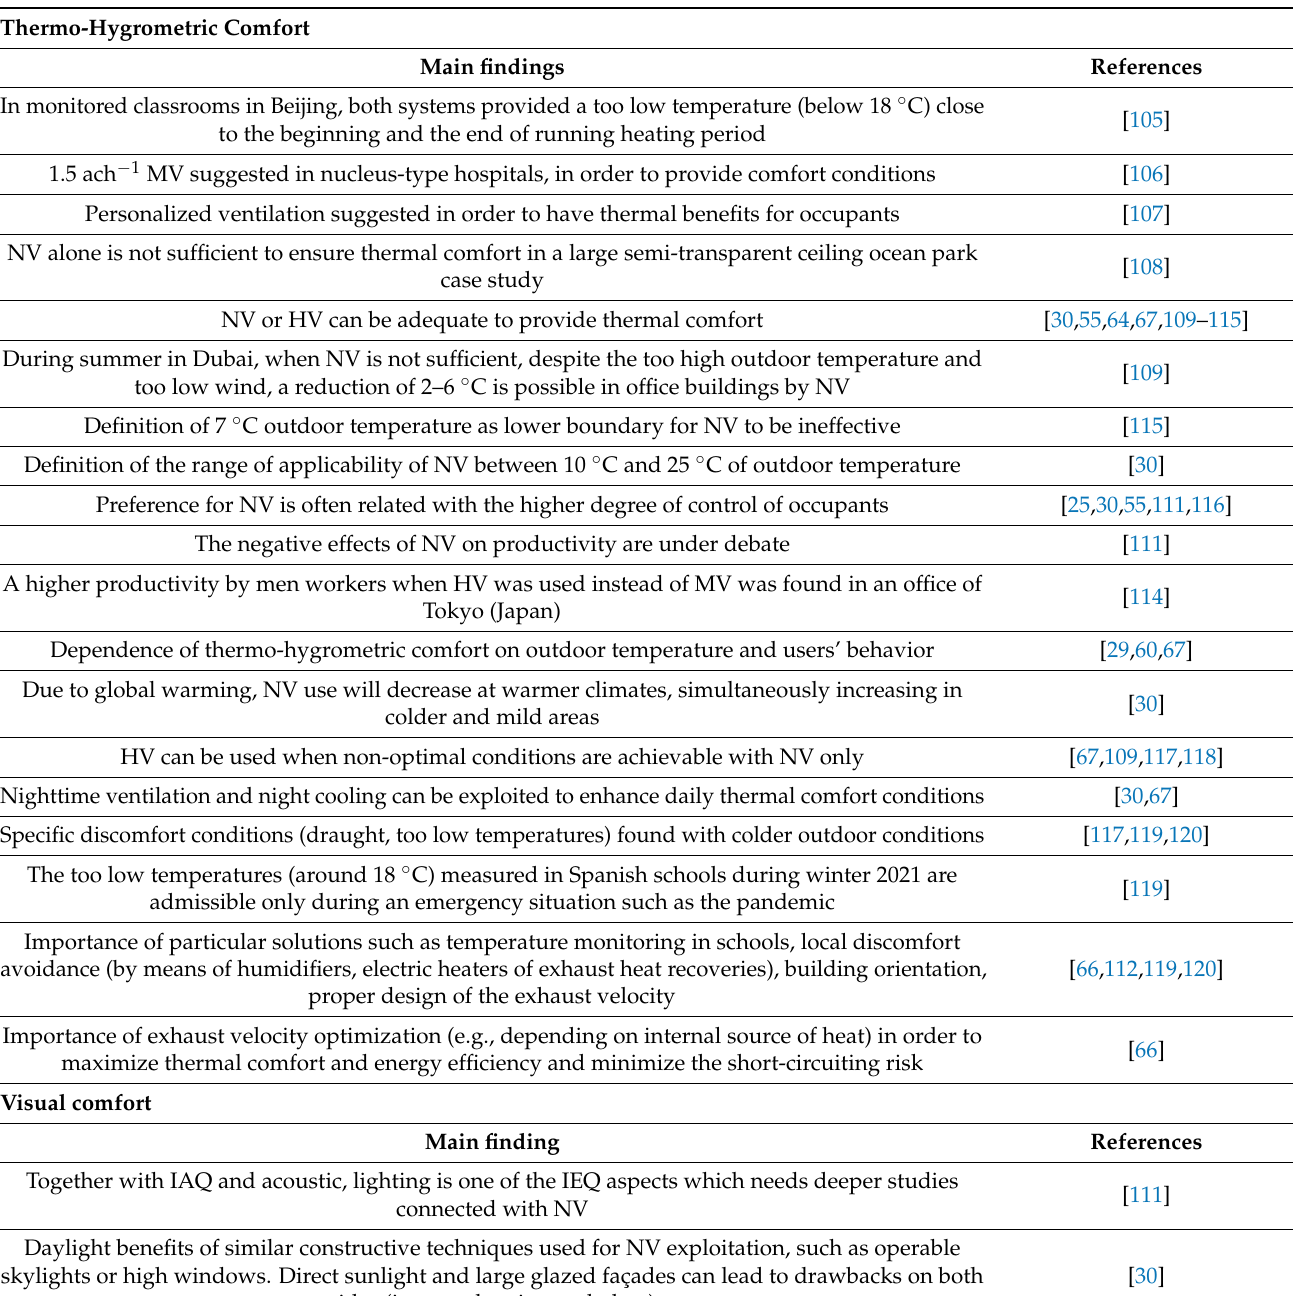
Table 2. Key findings related with non-residential